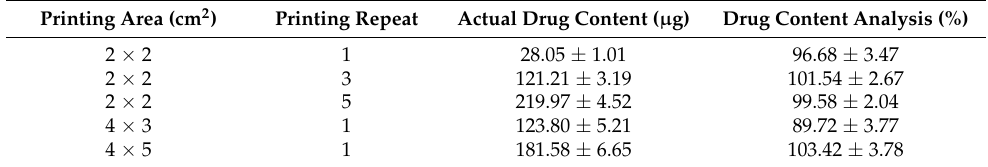
Table 3. Actual drug content in the prepared orodispersible films and percent of drug content analysis.